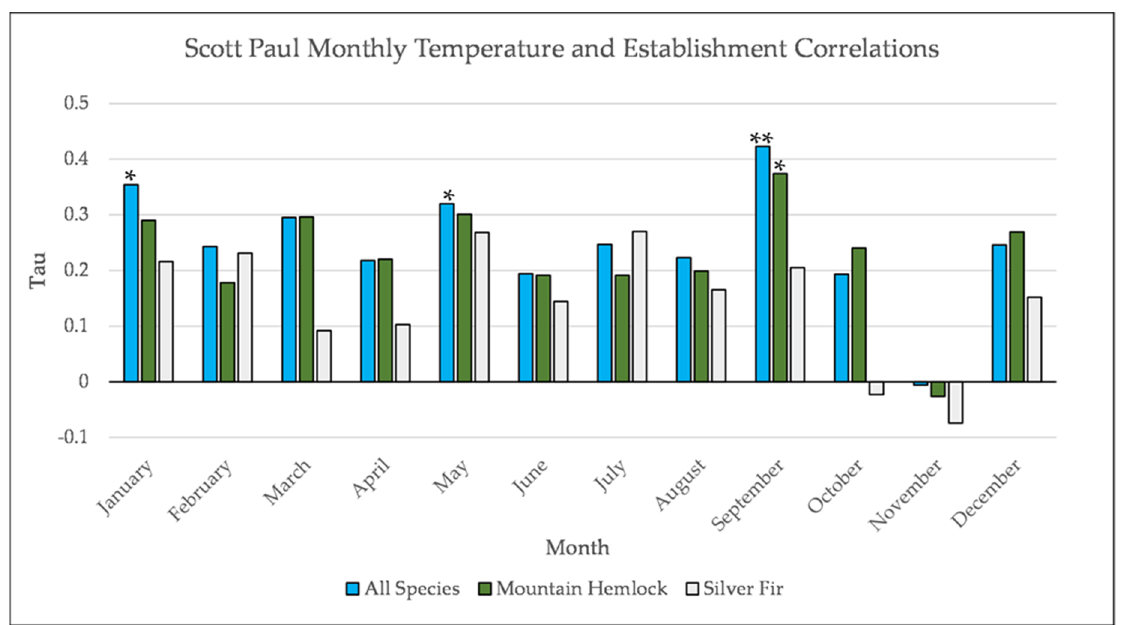
Figure A9. Partial Kendall’s correlations between establishment and annual and seasonal climate variables at Grouse Ridge. * = p -Value < 0.05, ** = p -Value < 0.01. Mean Annual Temperature (MAT), Mean Growing Season Temperature (MGST), Mean Annual Precipitation (MAP), Mean Growing Season Precipitation (MGSP), Mean Water Year Temperature (MWYT), Mean Water Year Precipitation (MWYP), Frost Free Period (FFP), and Number of Frost-Free Days (NFFD).